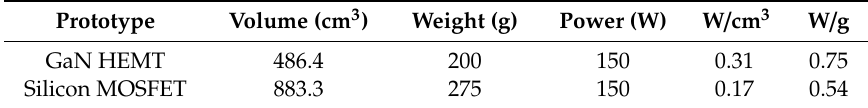
Table 3. Volume, weight and power density of the two implemented